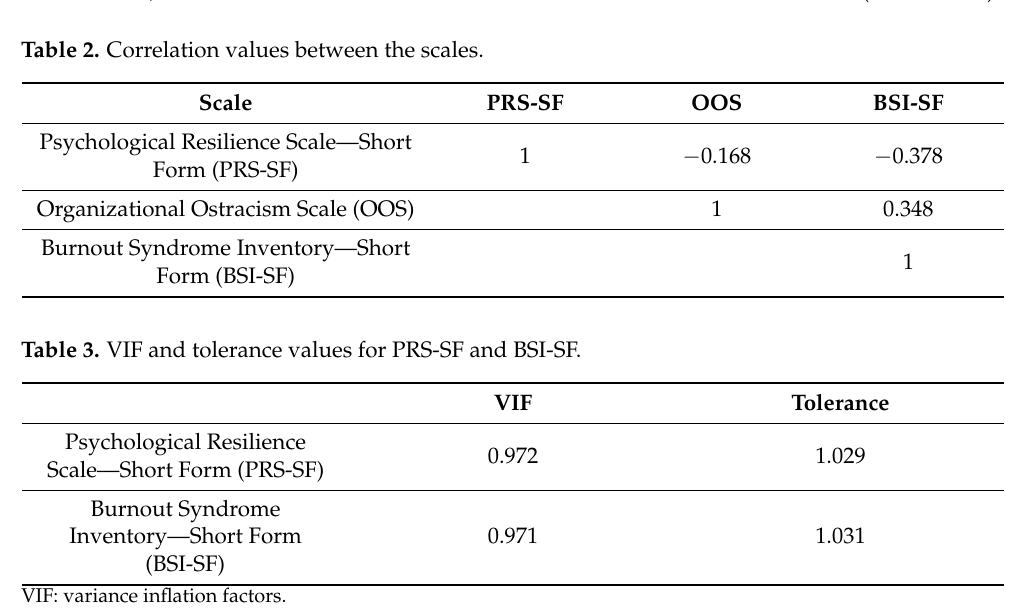
Table 4. Mean, standard deviation, skewness, and kurtosis values of the scales (N = 309). Scale